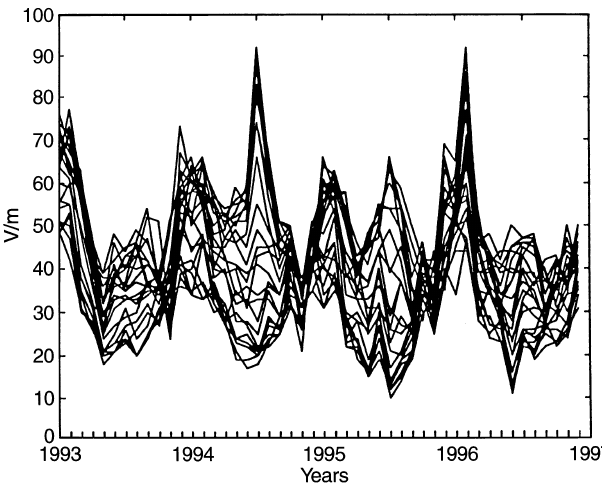
Fig. 2. Monthly means of the Nagycenk PG (in V/m) for each hour of the day in the interval between January 1993 and December